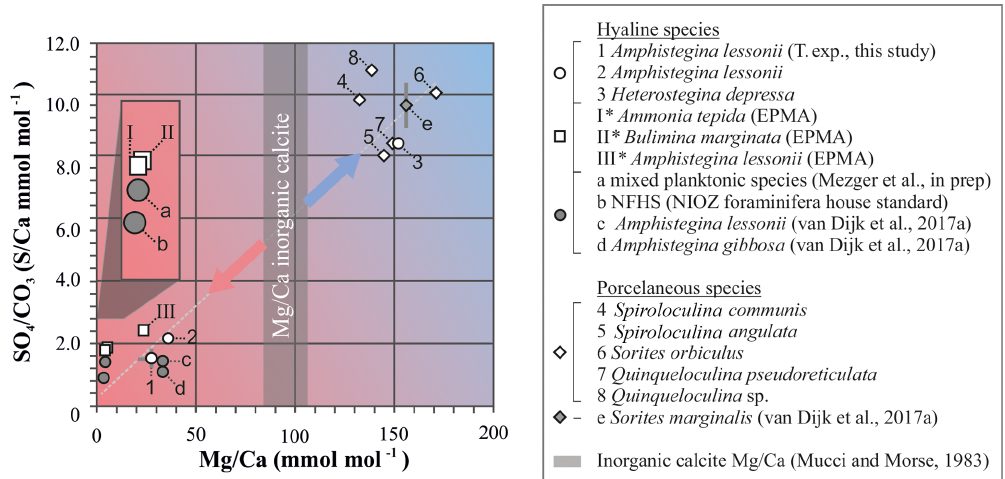
/ CO 2 − Figure 9. Average values of S / Ca, expressed as SO 2 − , versus Mg / Ca of different hyaline (circles) and porcelaneous (diamonds) 4 3 species of foraminifera of this study (open symbols) and other studies (grey symbols), including values obtained for the NFHS (for a description see Mezger et al., 2016). Culture experiments with varying salinity (c), temperature (1) and p CO 2 (d, e), min and maximum ranges are indicated by grey bars but in most cases fall within the symbol. Values of foraminiferal E/ Ca can be found in Table S4. Values for Mg / Ca of inorganic precipitated calcite of Mucci and Morse (1983) are indicated with the grey bars; SD is included. ∗ Average values for transect maps (square symbols; for details see Sect. 3.3) are